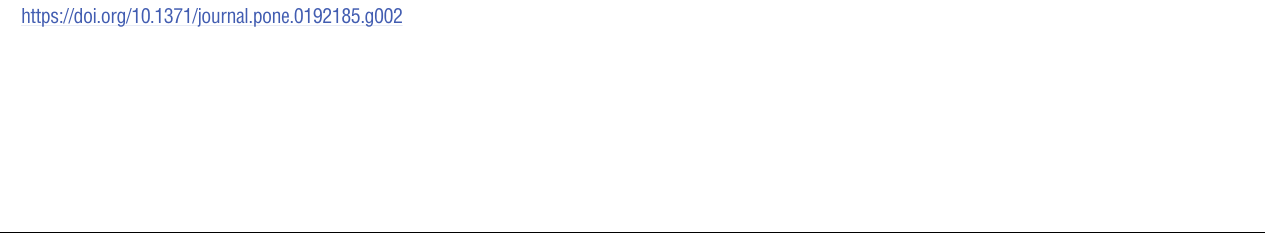
PLOS ONE | https://doi.org/10.1371/journal.pone.0192185 January 30,